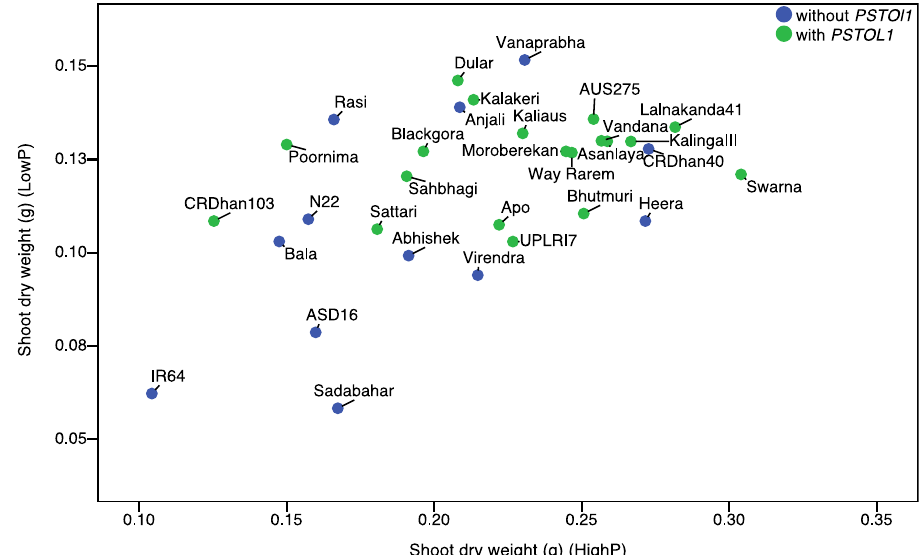
Figure 5. Relationship of shoot dry weight in low- and high P treatments. Genotypes in the upper right quadrant are vigorous under both conditions. The figure was edited for presentation using Affinity Designer 1.9.3 (https:// affin ity. serif. com/ en-